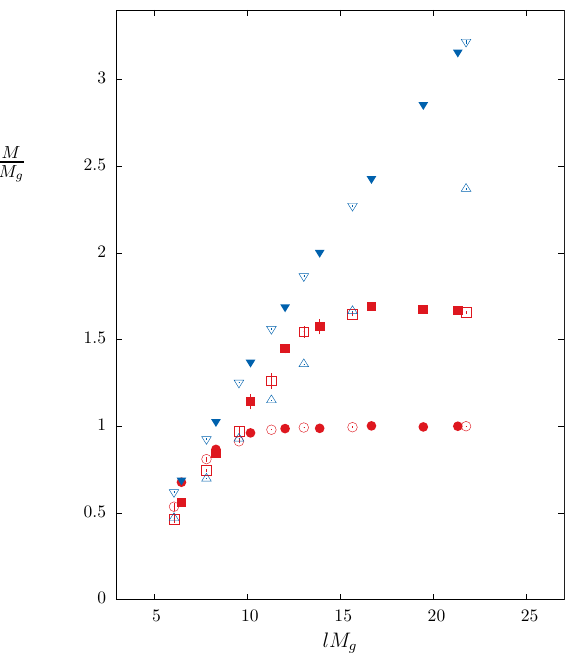
Figure 7 . Lightest scalar ( (cid:14) ) and tensor ( (cid:3) ) glueballs in SU(4) on various spatial volumes, l 2 , all in units of the in(cid:12)nite volume mass gap M g . And same for SO(6) ( (cid:15) ; (cid:4) respectively). Also shown is twice the fundamental (cid:13)ux loop energy in SU(4) ( 4 ) and in SO(6) ( H ), and the k = 2 (cid:13)ux loop energy in SU(4) ( O